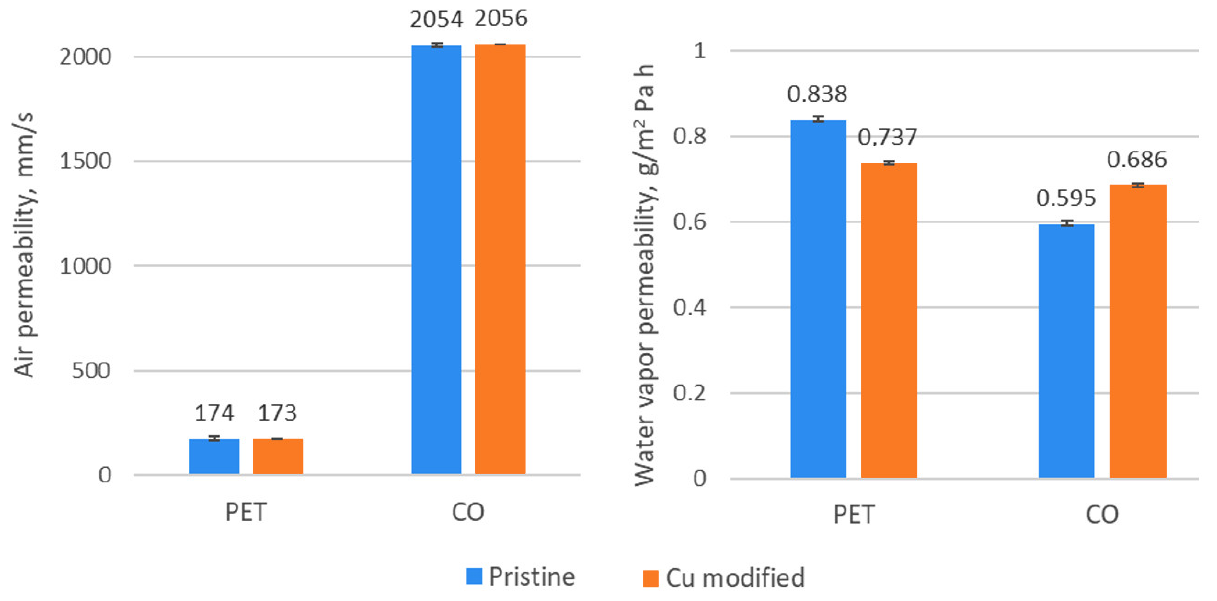
Figure 6. The values of air and water vapour permeability for pristine and Cu modified textile struc- tures.